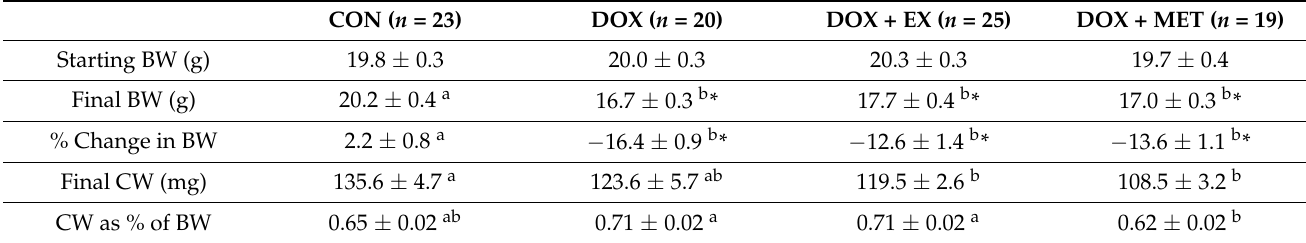
Table 1. Average mouse body weight (BW) and calf weight